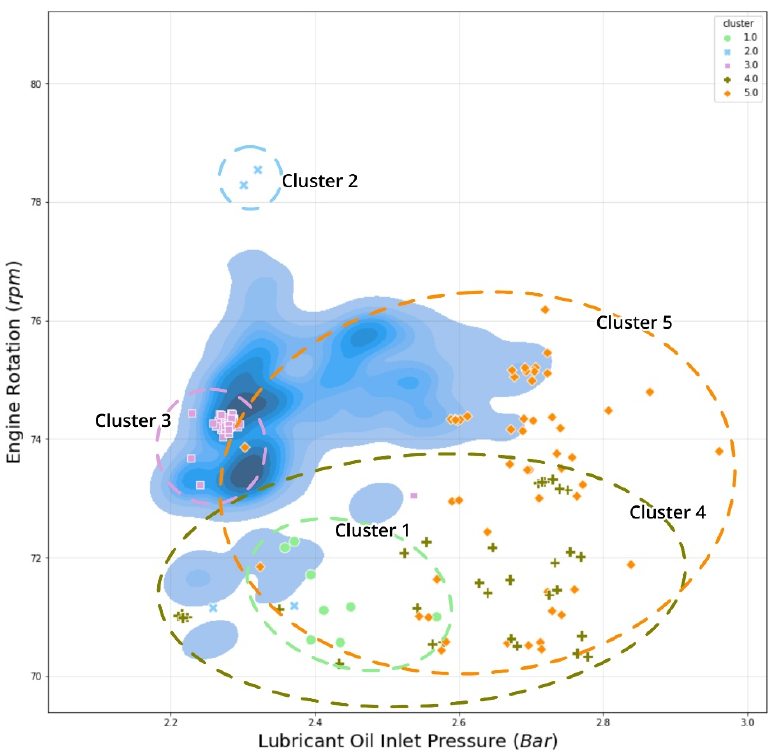
Figure 17. Pressure of lubricant oil inlet vs. RPM cross plot comparison with cluster distribution. Additionally, we analyzed the anomalous data point and the time series of (a) rota- tion per minute (rpm) and (b) speed over ground, as shown in Figure 18. As shown in the figure, the majority of data points in clusters 1, 3, 4, and 5 involved a rapid vessel speed shift. This indicates that the anomaly could be related to acceleration or deceleration, which may result in engine damage.